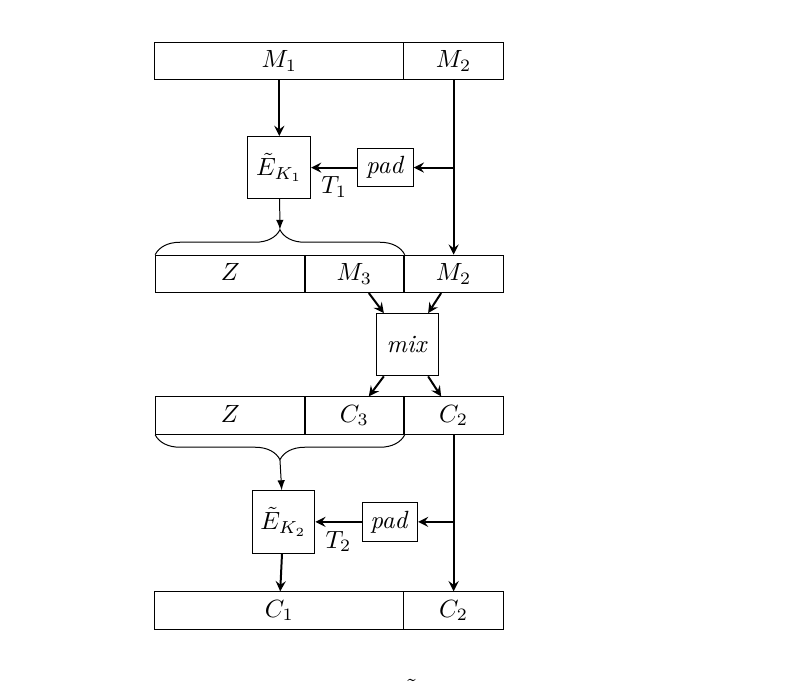
Figure 1: Encryption of length doubler LDT, with ˜ E a tweakable block cipher and mix a mix